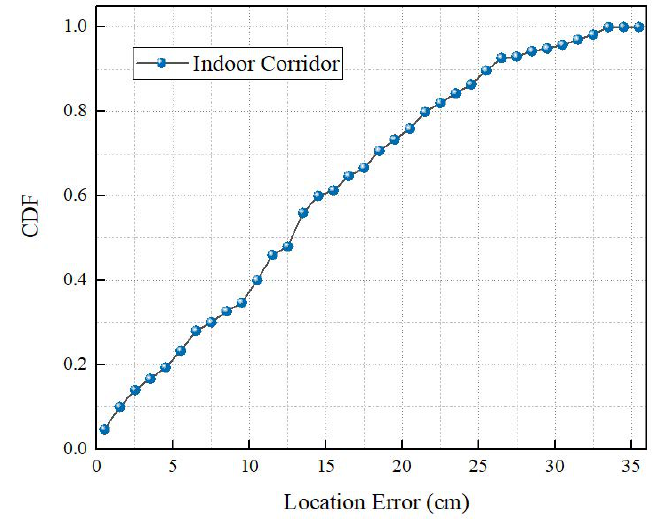
Figure 13. Indoor localization performance.